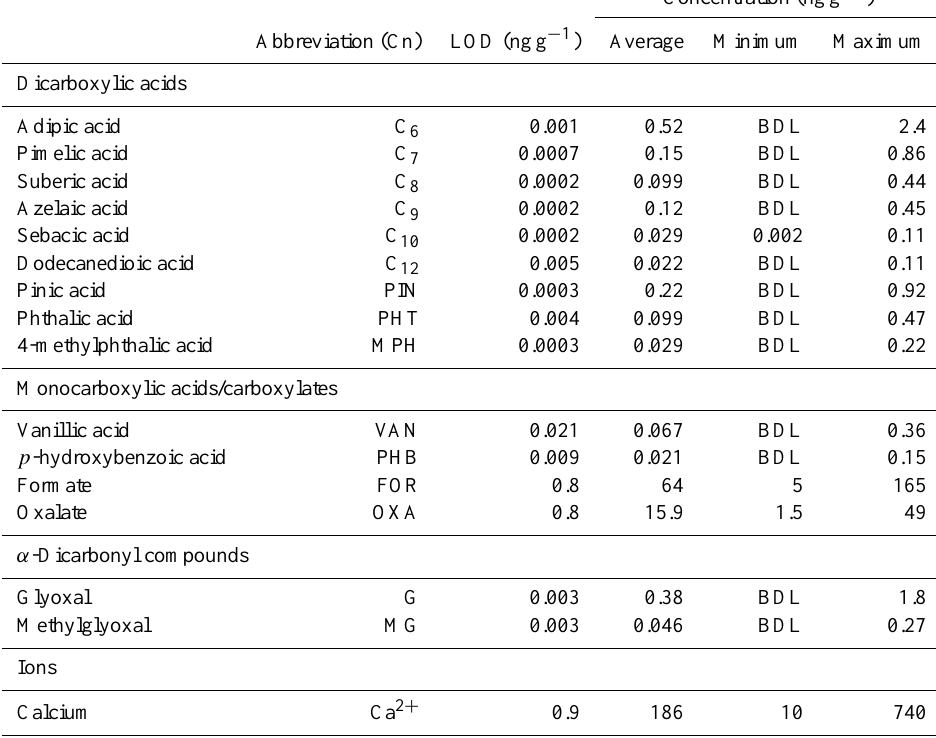
Table 1. Limits of detection (LOD) and obtained concentrations of dicarboxylic acids, monocarboxylic acids, α -dicarbonyls, and Ca 2 + analyzed in the Grenzgletscher ice core (BDL refers to below detection